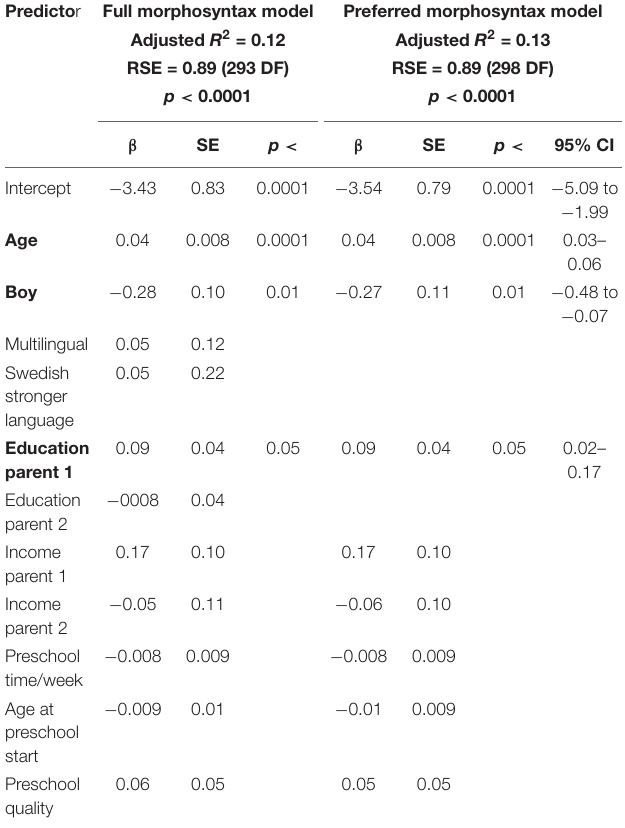
Standardized estimates, standard errors, and significance levels for predictors are included, as well as 95% confidence intervals for predictors in the preferred model. Adjusted R 2 and residual standard error displayed for the full model and the preferred model. Significant predictors in bold